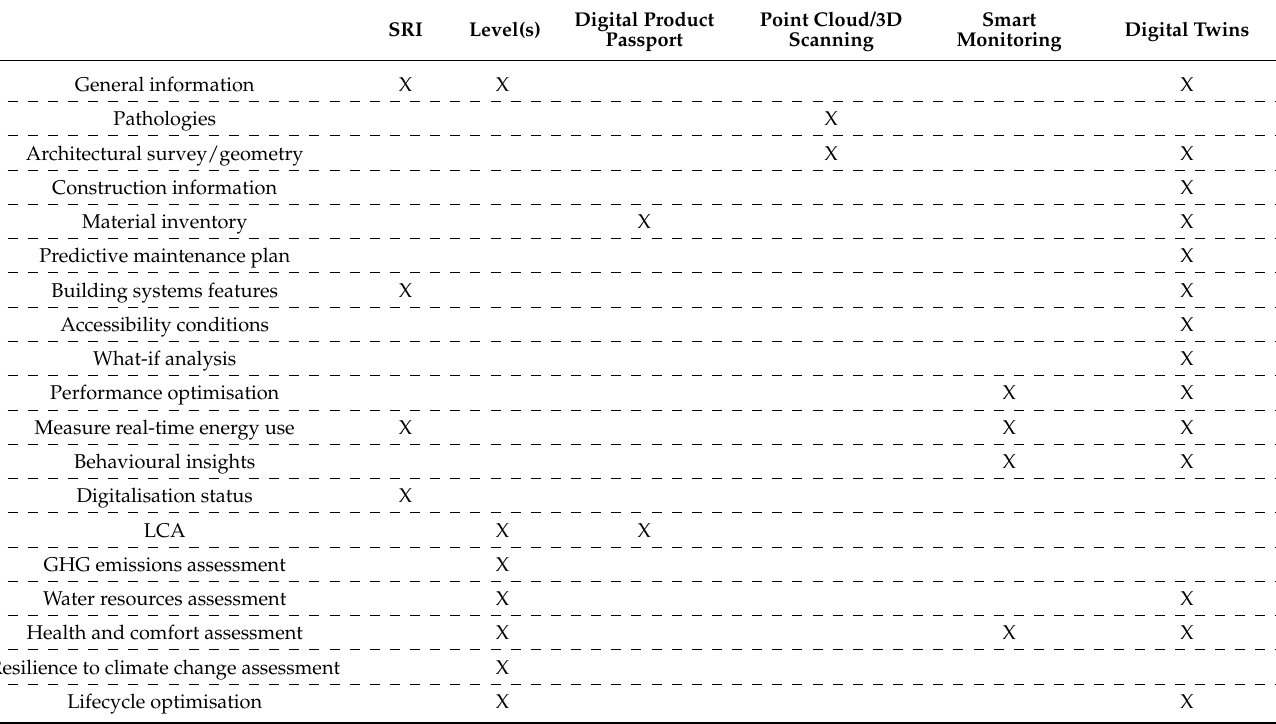
Table 3. Summary of data provided by each upcoming source, including additional information which is not included within the set of relevant